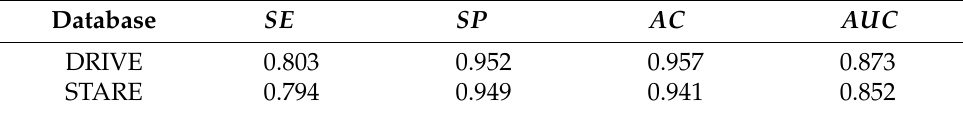
Table 6. Observation of Performance on Pathological